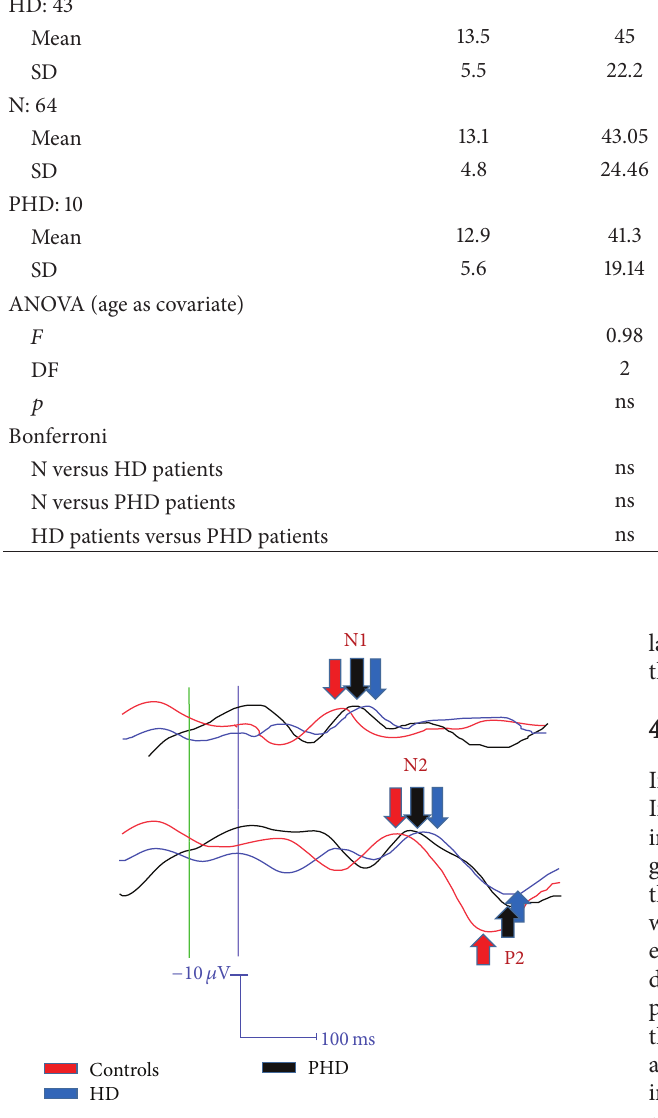
Figure 1: Grand average of N2P2 vertex complex computed in normal subjects (N) (64), HD (Huntington’s disease) patients (43), and PHD (presymptomatic HD) subjects (10). The N2 and P2 components are indicated with colored